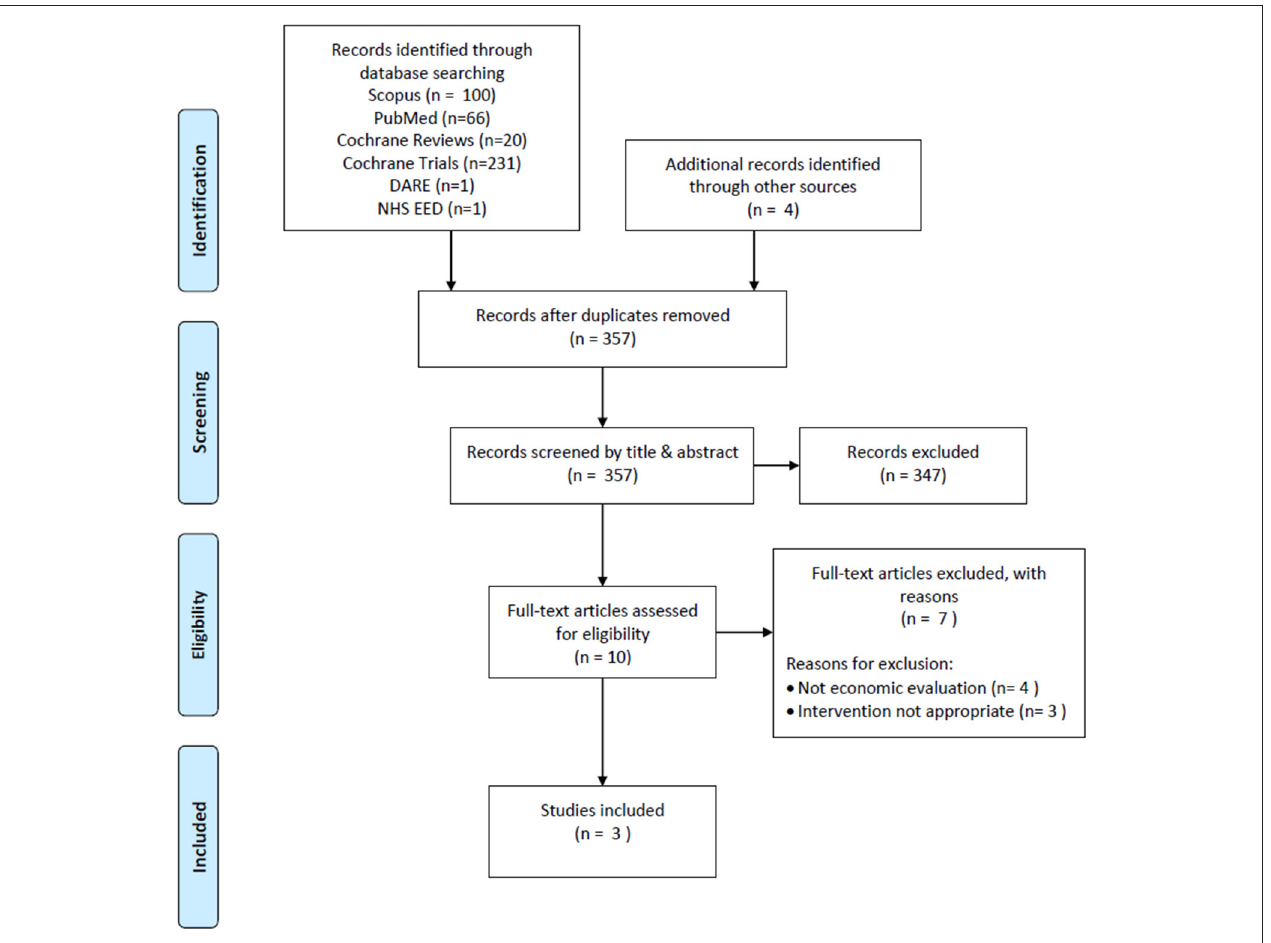
FIGURE 1 | PRISMA flow